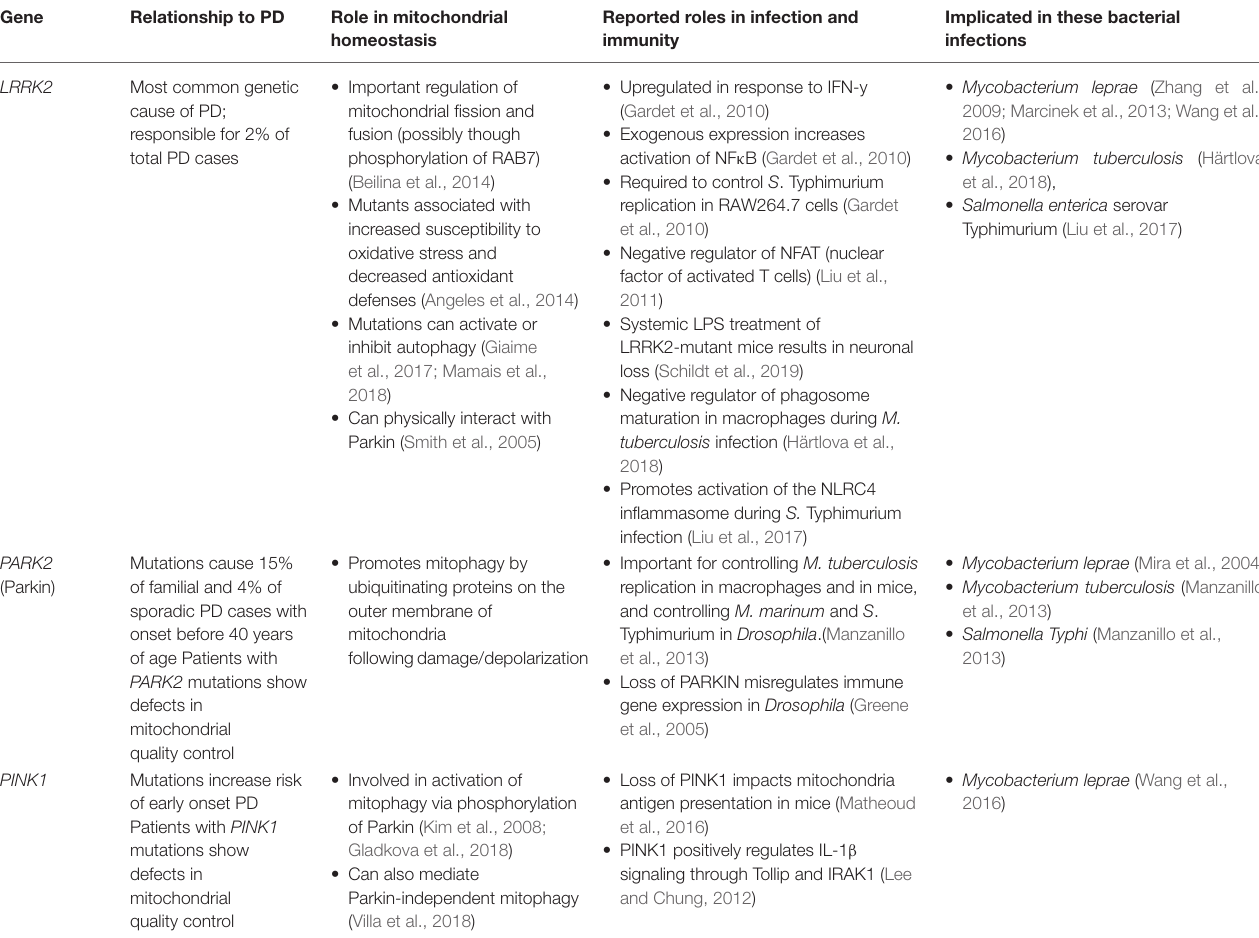
TABLE 1 | Genes associated with susceptibility with to mycobacterial infection and Parkinson’s Disease. Gene Relationship to PD Role in mitochondrial homeostasis